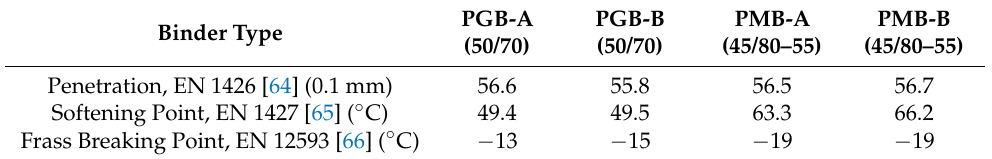
Table 2. Characterization of the paving-grade and polymer-modified bitumen used in the study.